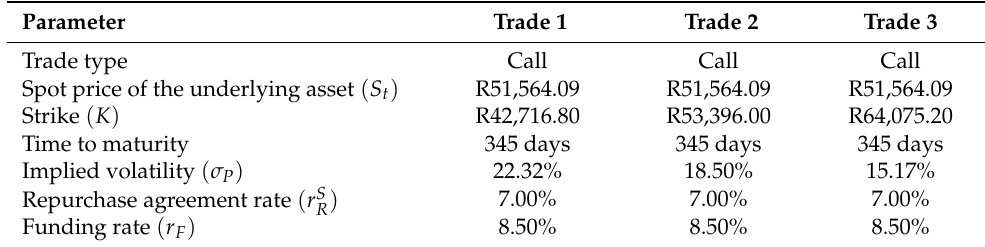
Table 8. Zero collateral trade